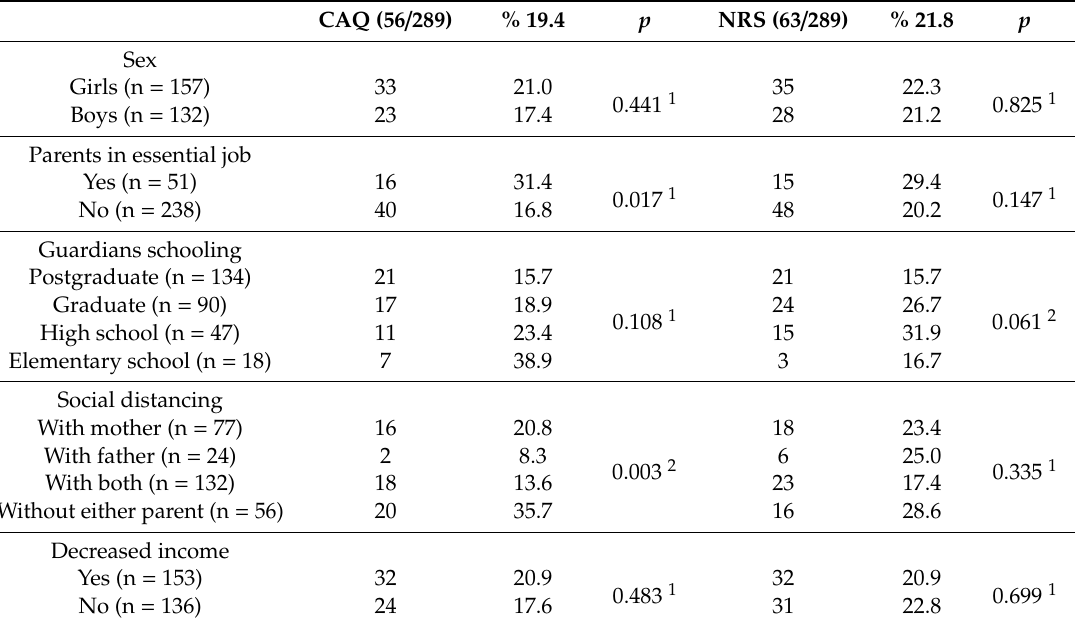
Table 2. Prevalence of anxiety (CAQ score ≥ 9; NRS score >